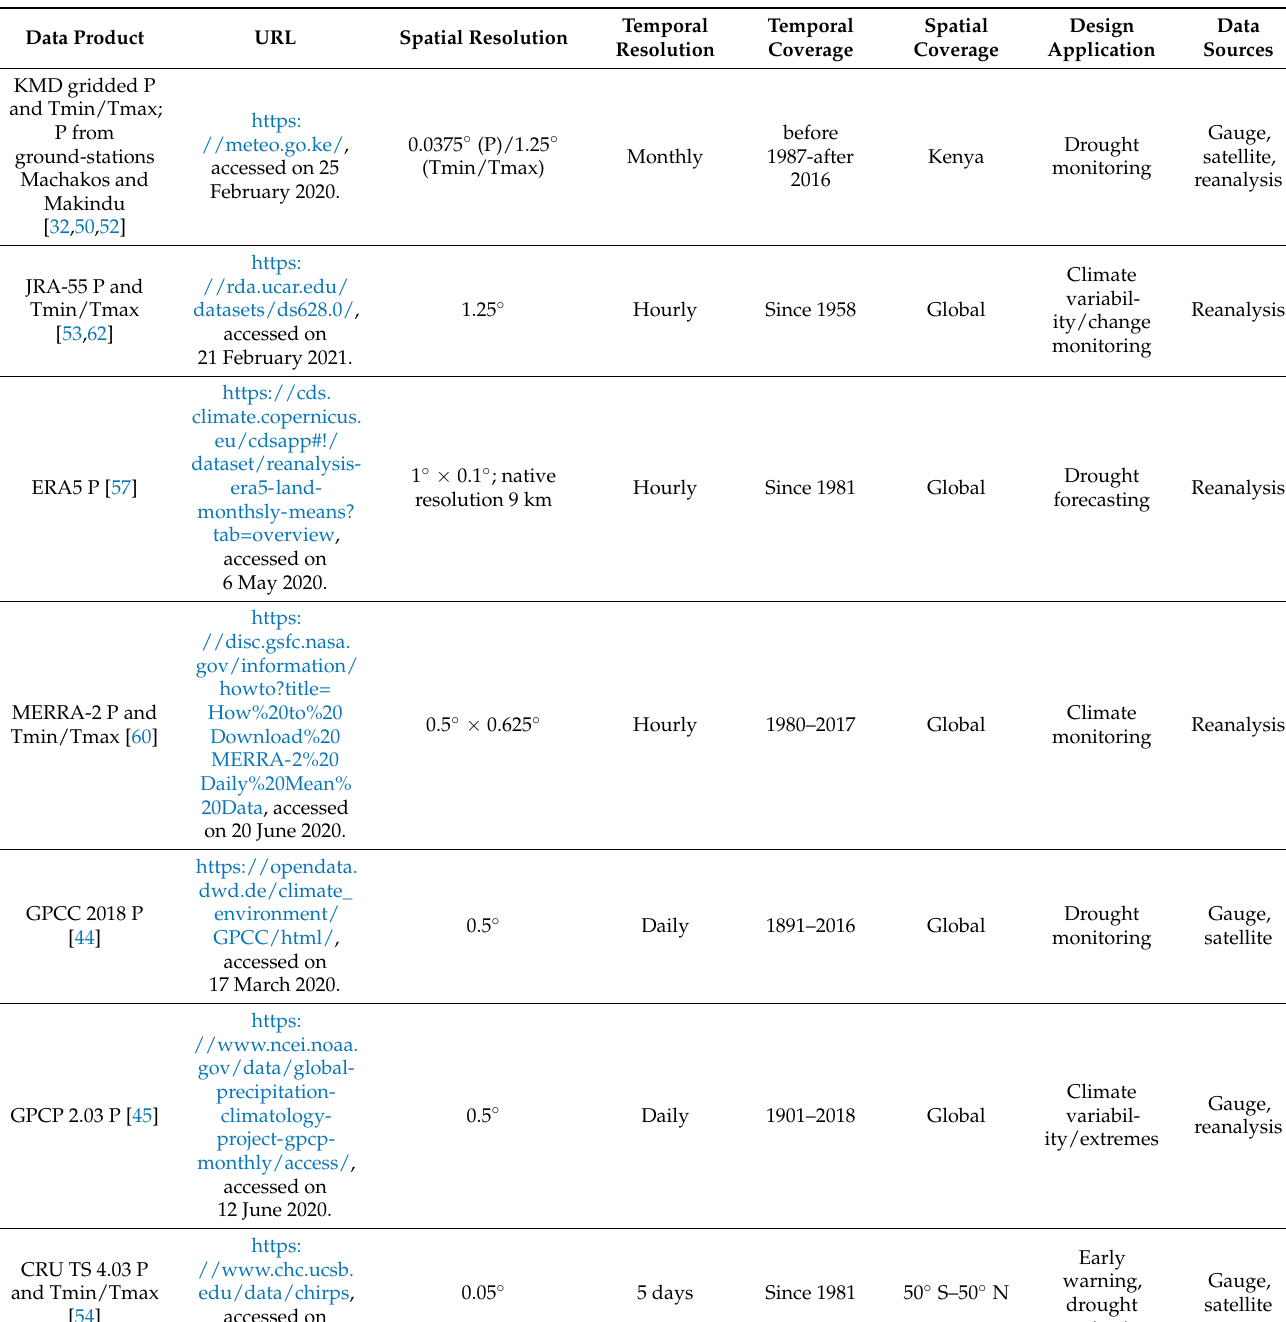
Table 1. Rainfall (P) and temperature (Tmin/Tmax) products used in the computation of SPEI. Original daily data were aggregated to a common monthly resolution. Only validated and widely used products with a length of more than 30 years were used. Data Product Spatial Resolution